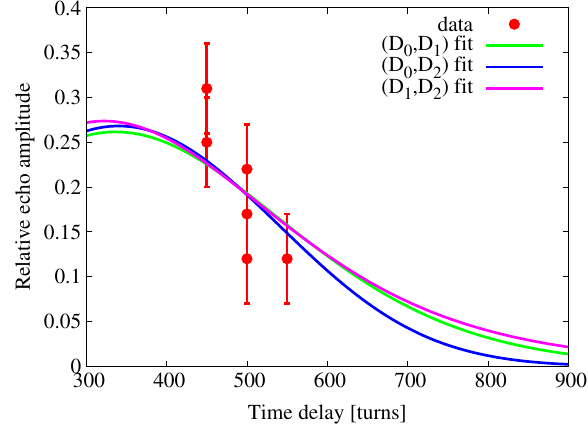
FIG. 4. Comparison of the echo amplitude vs the time delay between the dipole and quadrupole kicks. The data are shown with error bars, while the fits are shown with the three models discussed in the text.